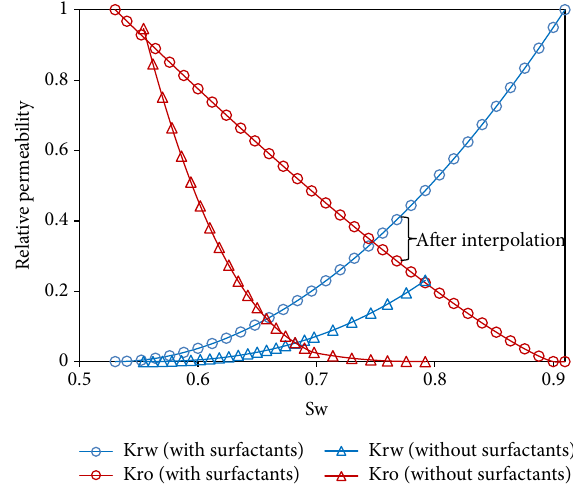
Figure 5: Relative permeability curves (with surfactants, without